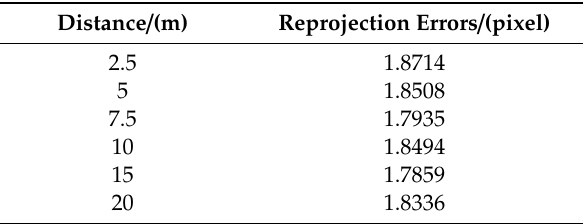
Table 4. Reprojection errors at di ff erent distance.